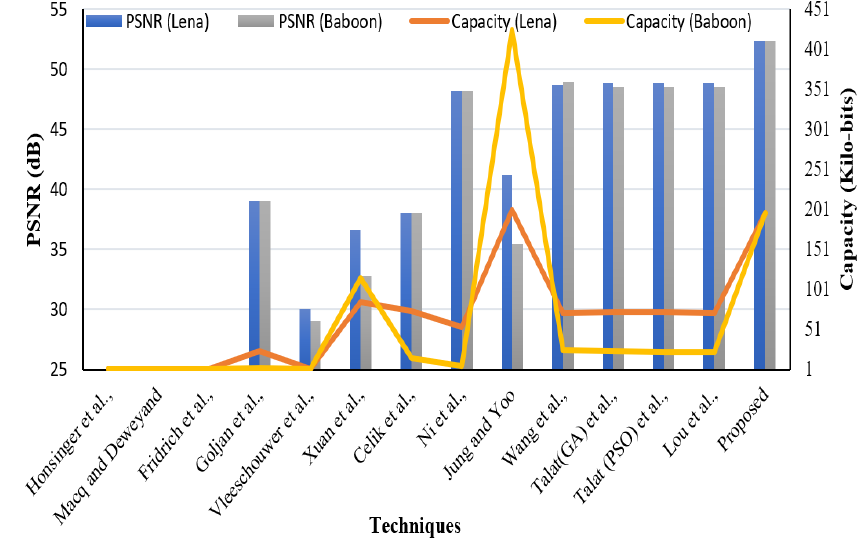
Figure 7. Perceptual transparency comparison.